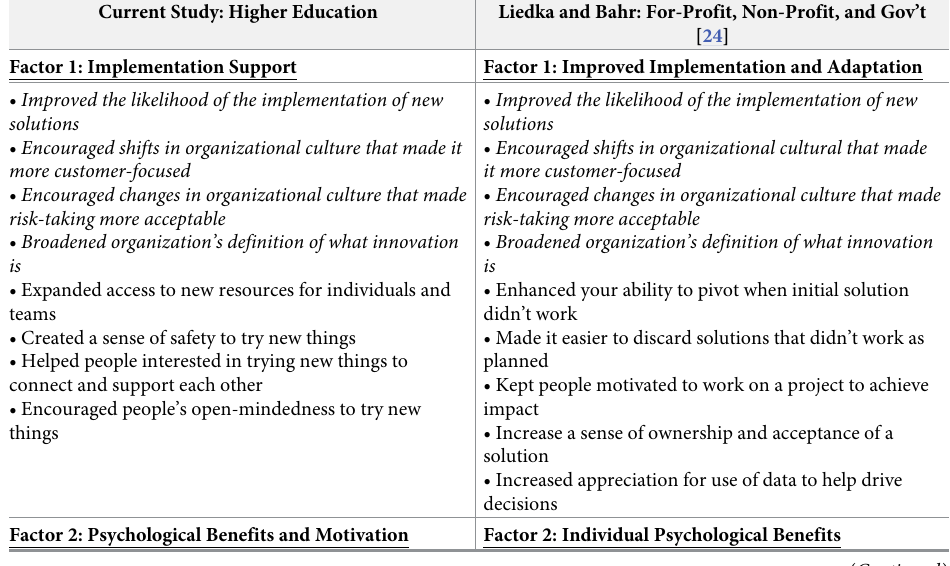
Table 5. Side-by-side comparison of DT outcome factors in higher education and DT outcome factors in for- profit, non-profit, and Gov’t